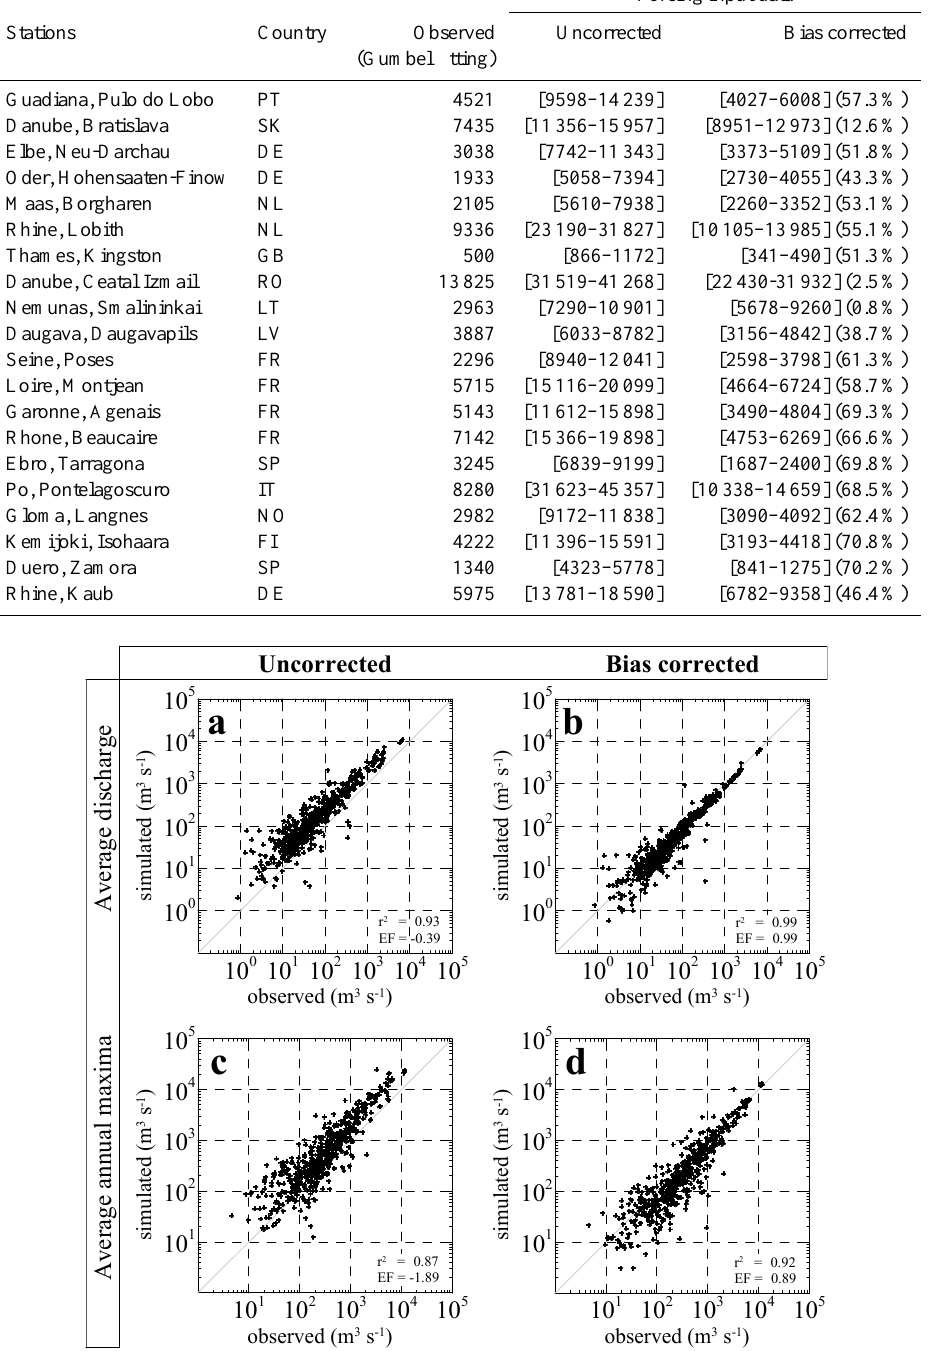
Fig. 10. Observed versus simulated average discharge (a, b) and average annual maximum discharge (c, d) for each of the 554 stations depicted in Fig. 1 for the control period 1961–1990. Left and right columns show hydrological simulations driven by uncorrected and bias corrected climate data,